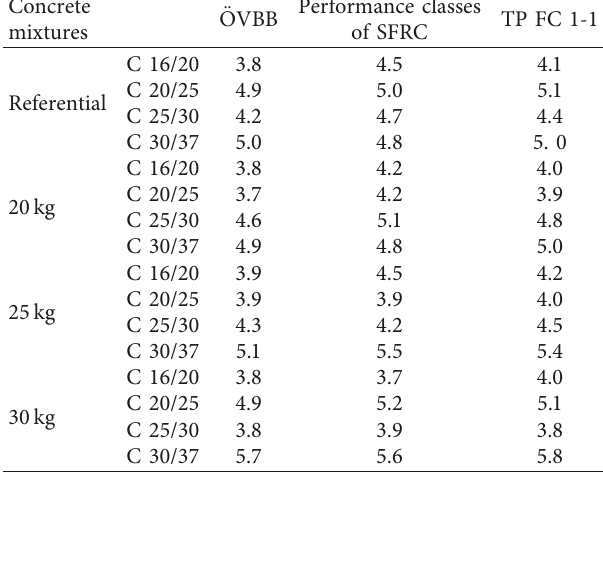
Table 5: Assessment of the tensile strength in bending according to the Austrian standard ( ¨OVB) [20], Performance classes of SFRC [6], and TP FC 1-1 [10] in MPa.